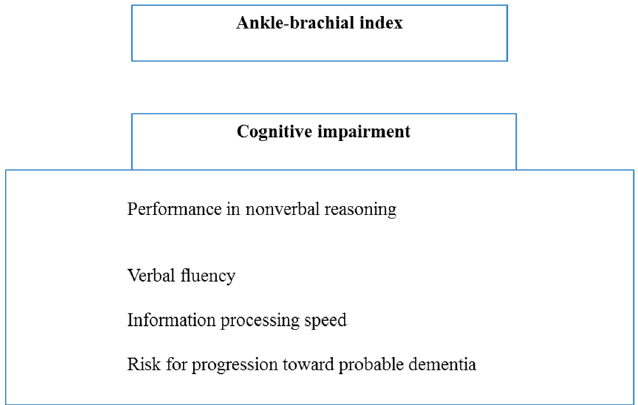
Figure 2. Ankle-brachial index is an indicator not only for PAD, but also for cognitive